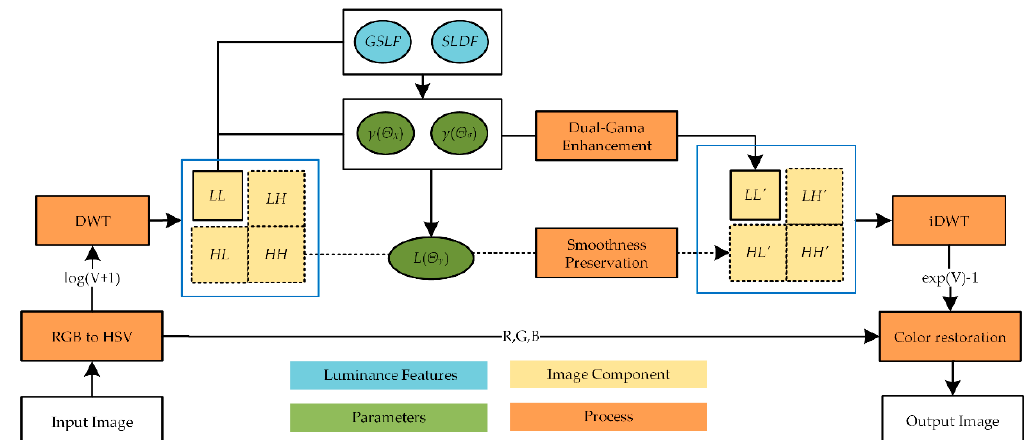
Figure 2. Flowchart of GLAGC method.